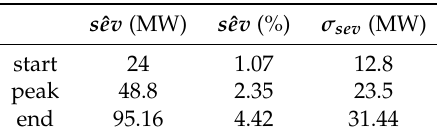
Table 1. Worst-case outage severity (load